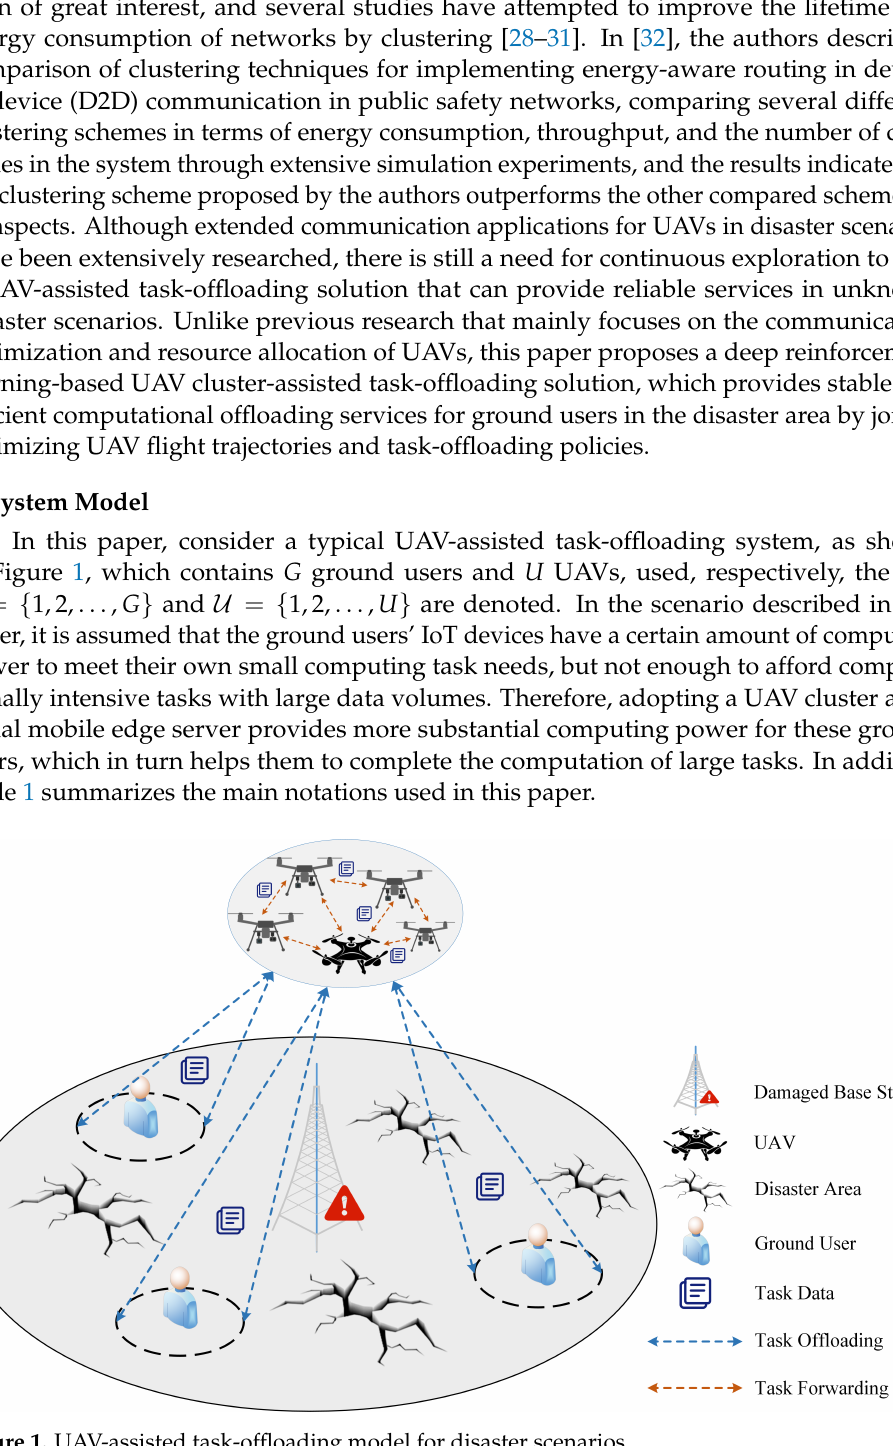
Figure 1. UAV-assisted task-offloading model for disaster